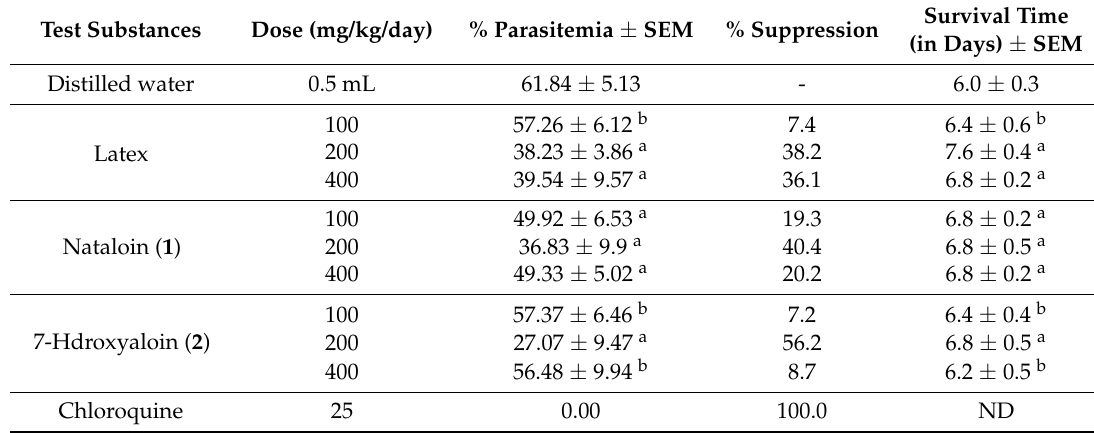
Table 1. Percentage suppression and mean survival time of Plasmodium berghei -infected mice after treatment with the leaf latex of Aloe pulcherrima , nataloin ( 1 ) and 7-hydroxyaloin ( 2